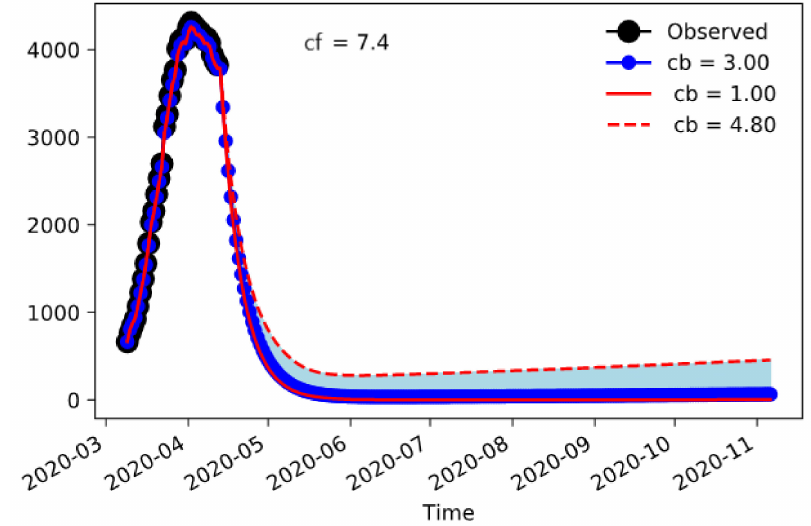
Figure 5. Emilia-Romagna’s COVID-19-associated hospitalizations with nudging between 9 March and 12 April, and forecasting until November